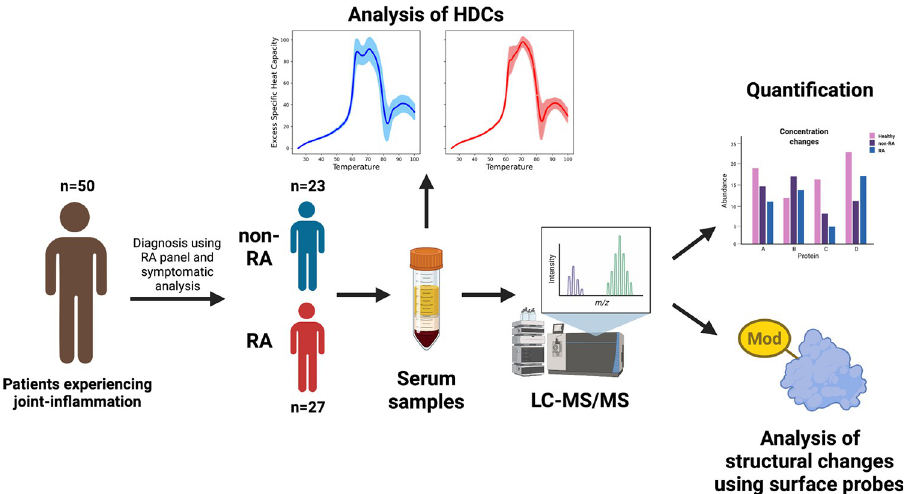
Fig 1. Experimental flow. Blood serum samples from subjects that had physician ordered RA panels were used (n = 50). Based on clinical diagnosis from medical professionals, the samples were separated into an RA group (n = 27) and a non-RA group (n = 23). DSC was used to obtain the HDCs, and a characteristic shift was seen between groups. LC/MS-MS experiments were performed to determine the mechanism behind this shift. Quantification and surface amino acid reactivity analyses were performed to determine significant differences in serum proteins between RA and non-RA